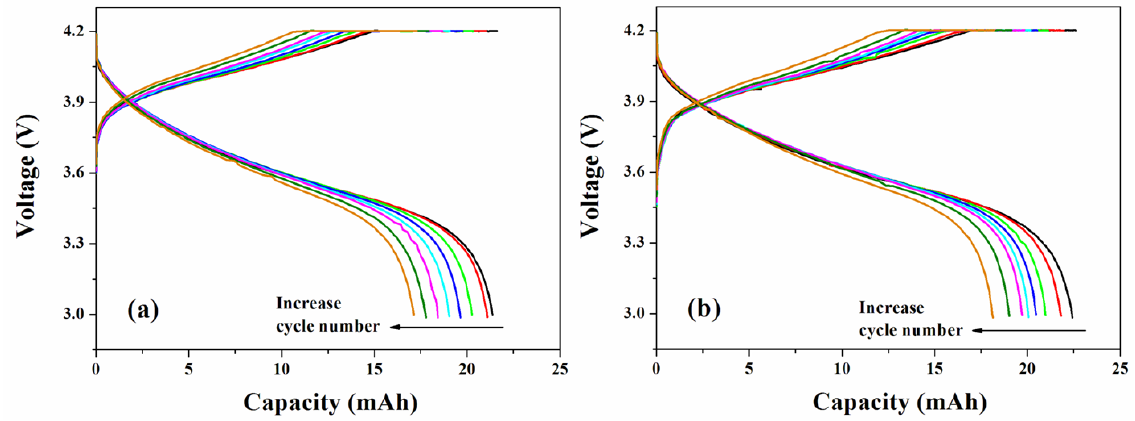
Figure 7. Charge-discharge profiles of the LIPB cells fabricated with (a) PE and (b) modified PE membranes as a function of cycle number. Reproduced with permission from Reference [58]. © 2009 Elsevier